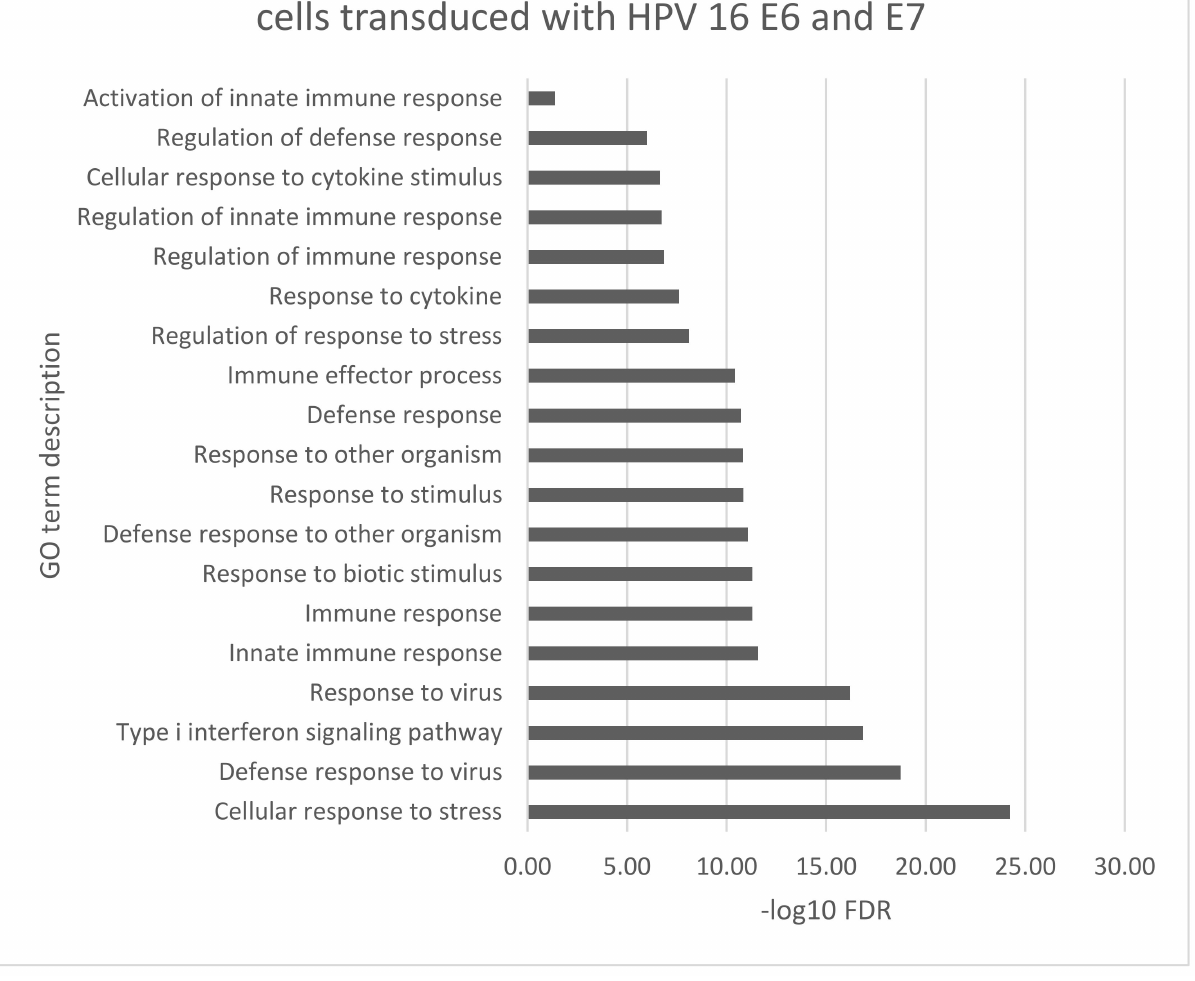
Figure 4. Biological GO terms related to defense immune responses were associated with the proteins with significantly increased expression (adjusted p -value ≤ 0.02) by ≥± 1.5-fold change in keratinocytes transduced with HPV16 E6 and E7. FDR (False discovery